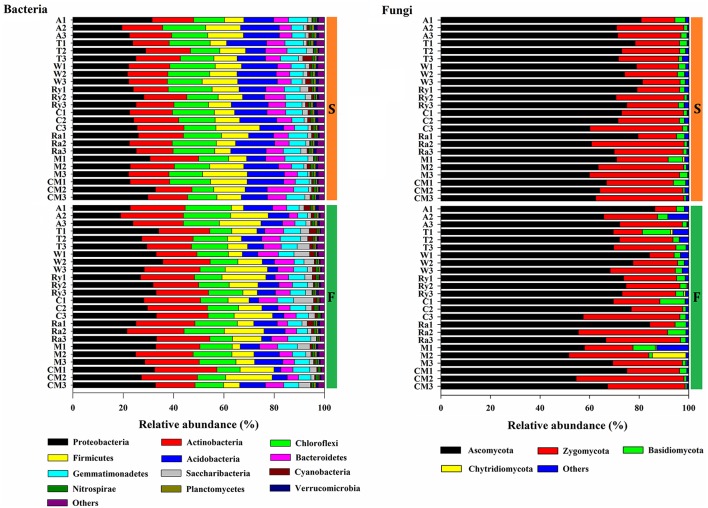
Changes in the relative abundances of bacterial and fungal phyla under different treatments in the spring (S) and fall (F) cropping seasons. Others includes phyla below 0.1% of relative abundance and the unclassified phyla.